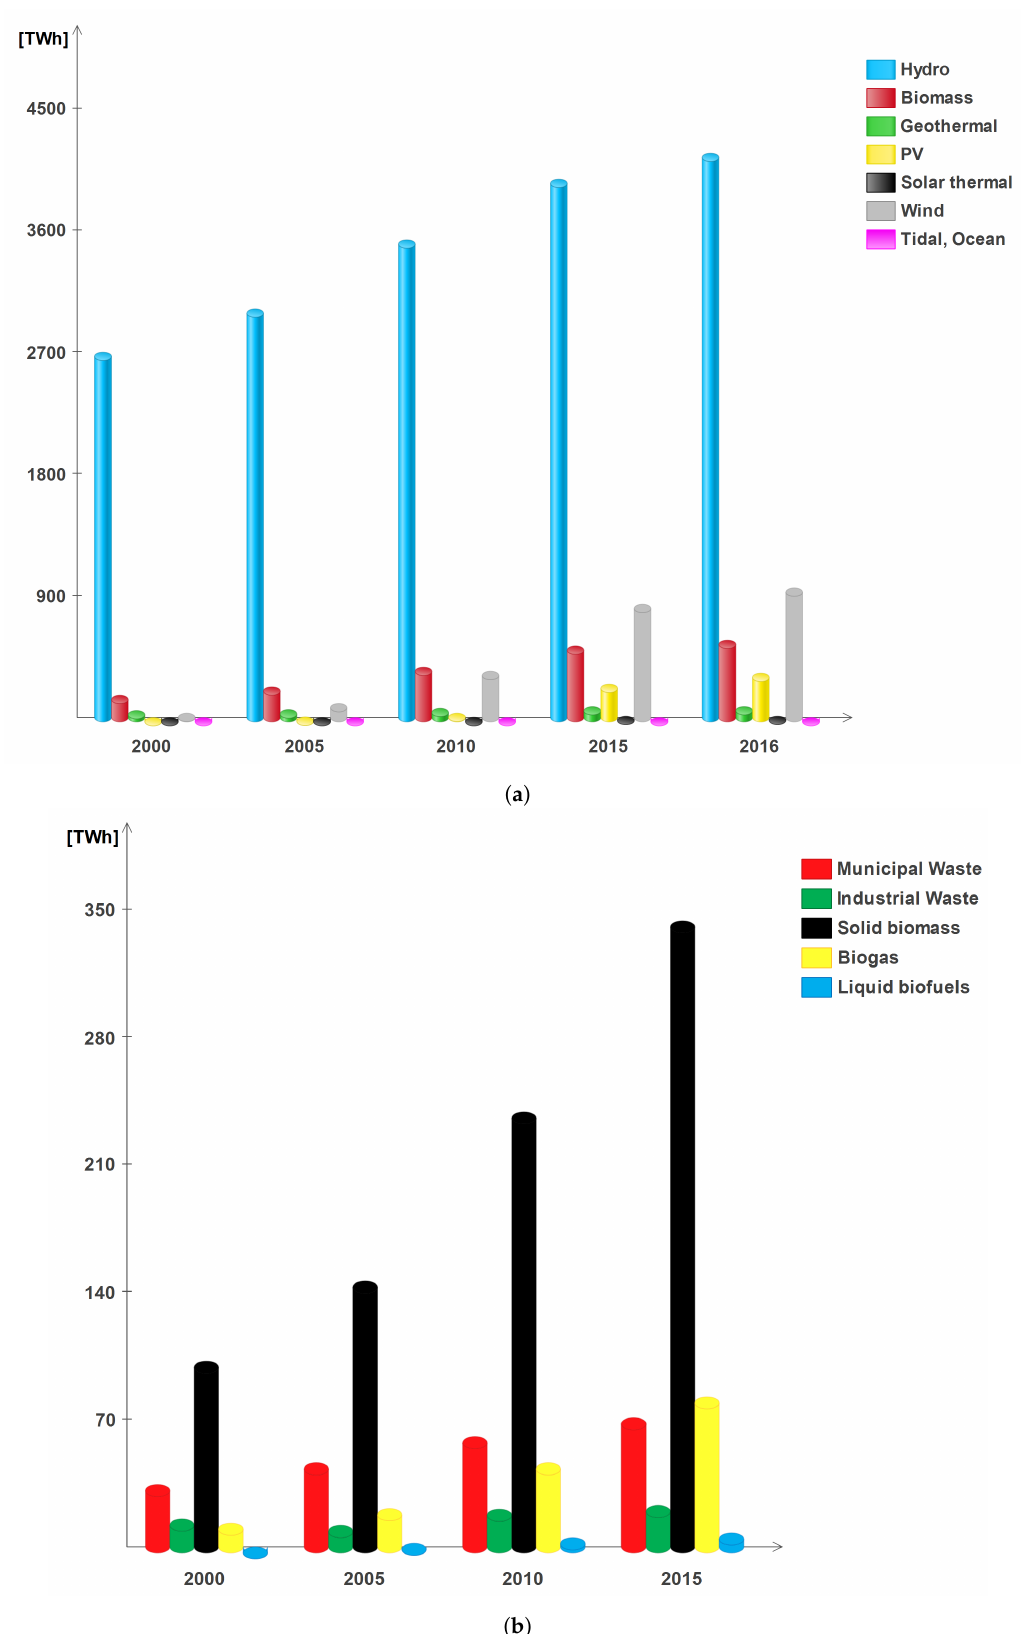
Figure 1. Electricity production from ( a ) Renewables and ( b ) Biomass. Data from: Reference